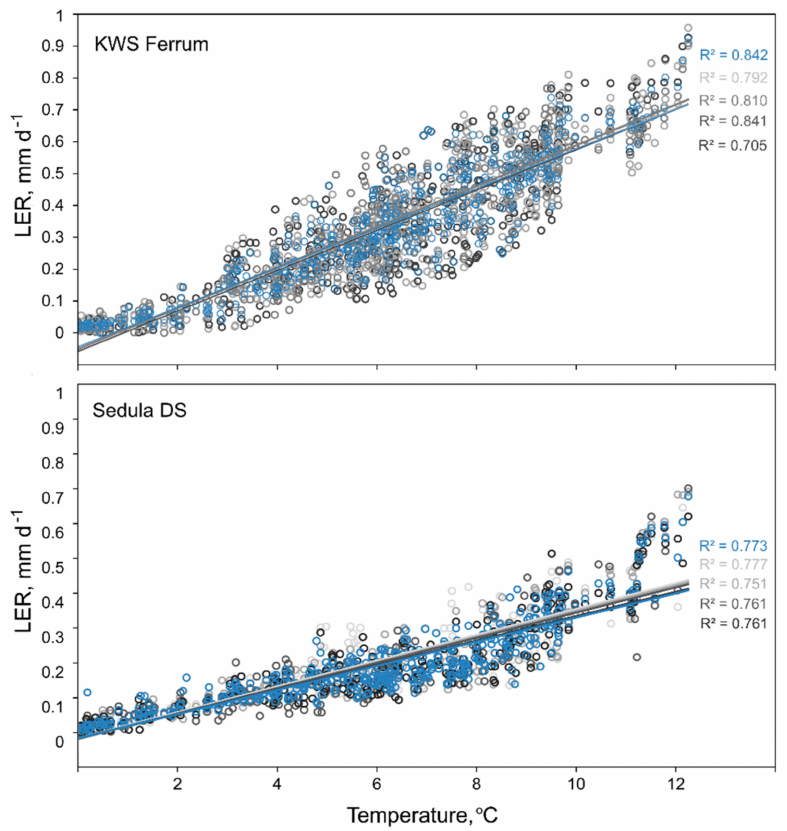
Figure 4. Linear correlations of leaf elongation rate (LER) and temperature for two contrasting cultivars ‘KWS Ferrum’ and ‘Sedula DS’. Differently shaded grey dots and lines indicate replications, and the blue line represents the mean linear regression fit over all